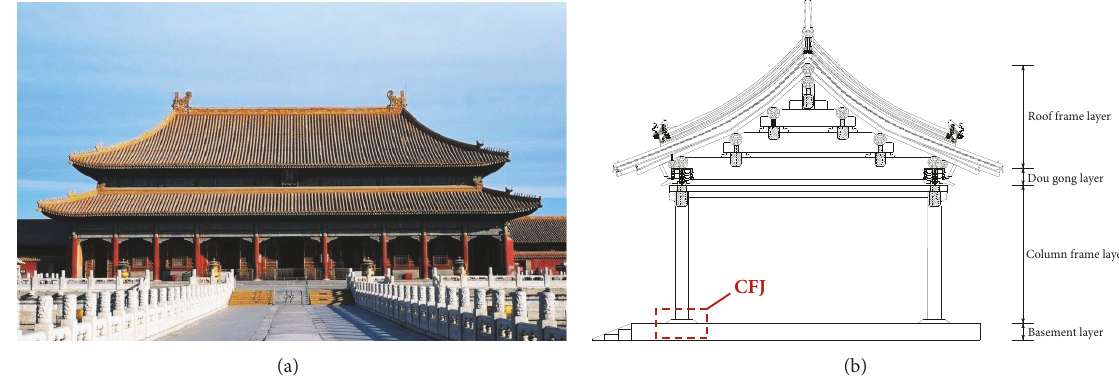
Figure 1: Typical traditional Chinese timber structure: (a) appearance; (b) constructional schematic.